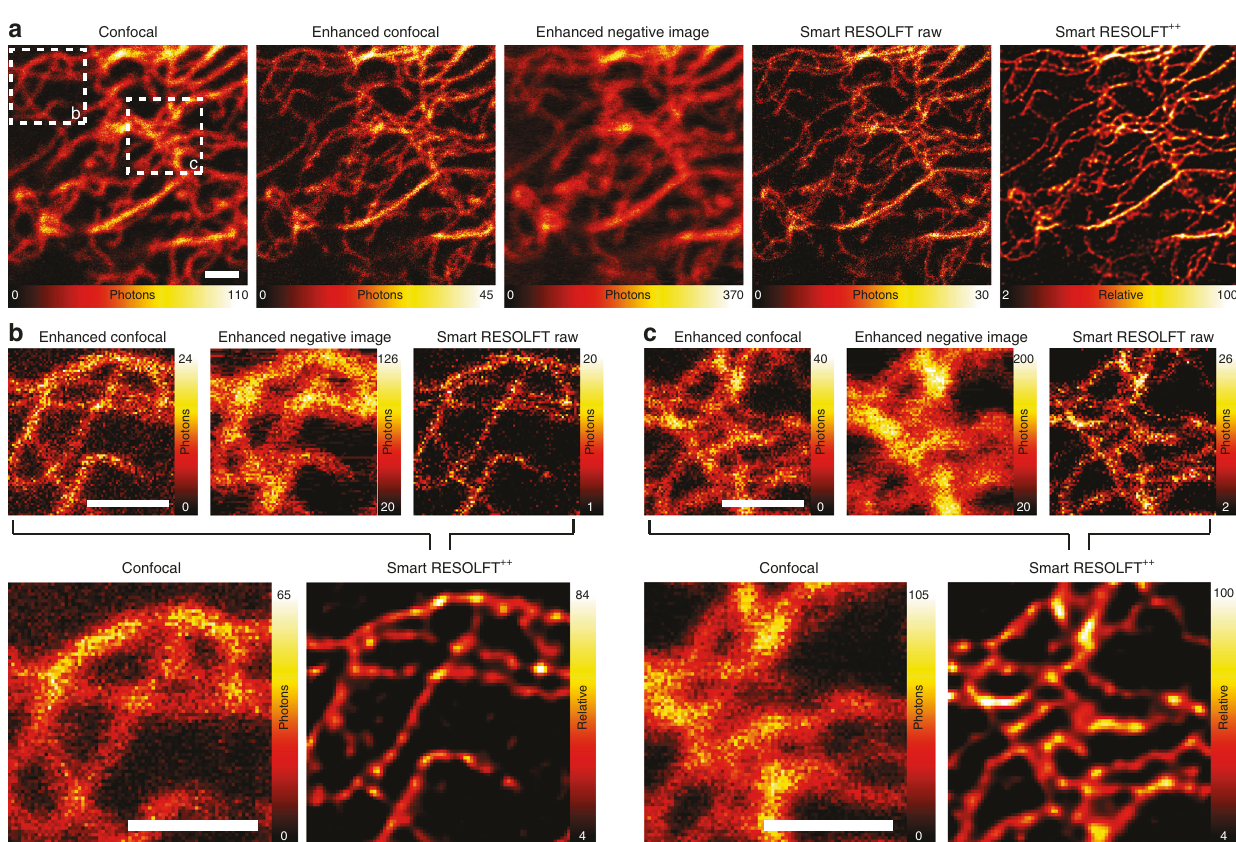
Fig. 3 Extended information content in smart RESOLFT single recording. a The enhanced confocal, the enhanced negative image and the smart RESOLFT are all recorded in a smart pixel by a single scan of the sample. Each structure of the sample is illuminated according to probe type 2. The images are then combined to form the smart RESOLFT ++ image through a multi-image deconvolution ( fi ve iterations). Included for comparison is also the confocal image. b , c Zoom of two regions of interest, which highlight the increased spatial resolution of the smart RESOLFT and smart RESOLFT ++ images in comparison to the negative confocal, confocal and enhanced confocal images. Scale bars are 1 µ m. RESOLFT REversible Saturable/Switchable Optical Linear